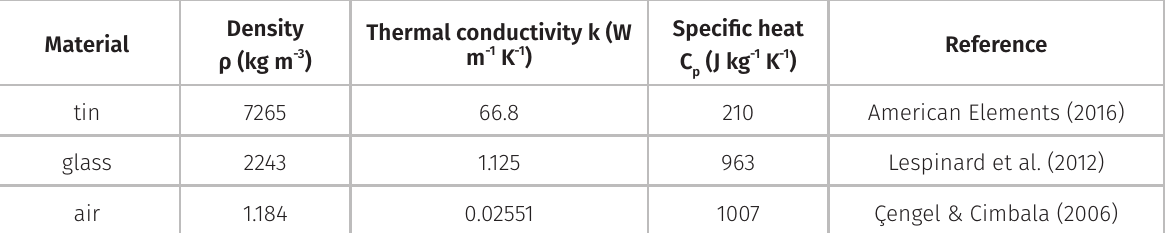
Table VI. Material properties which used in the definition of the subdomains considered in the models.